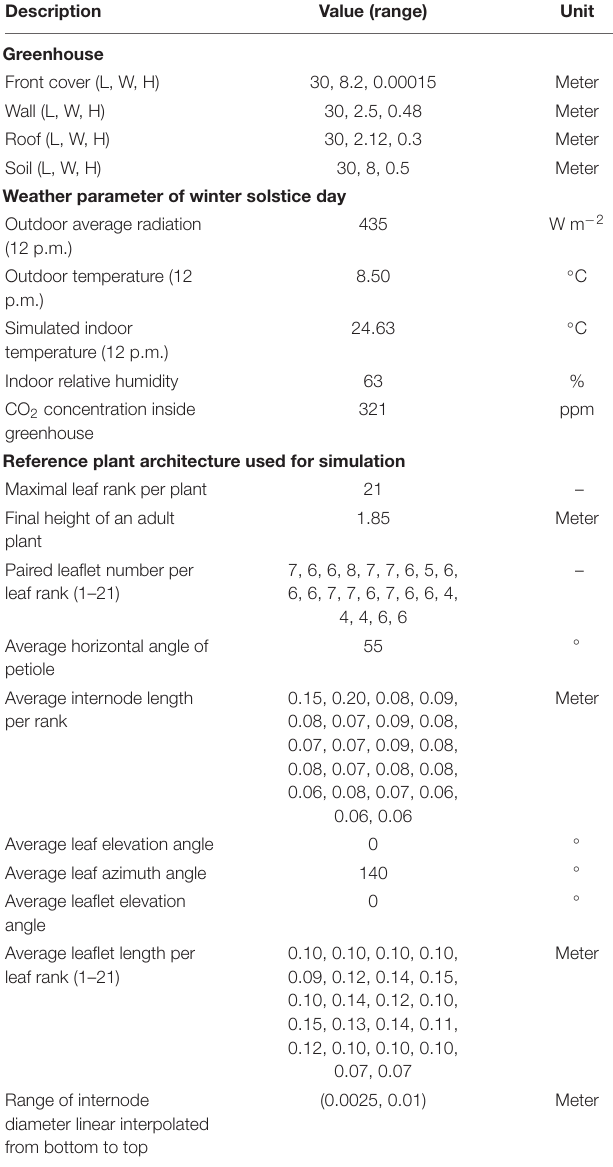
TABLE 1 | General simulation parameters for the LSG model and the reference tomato plant